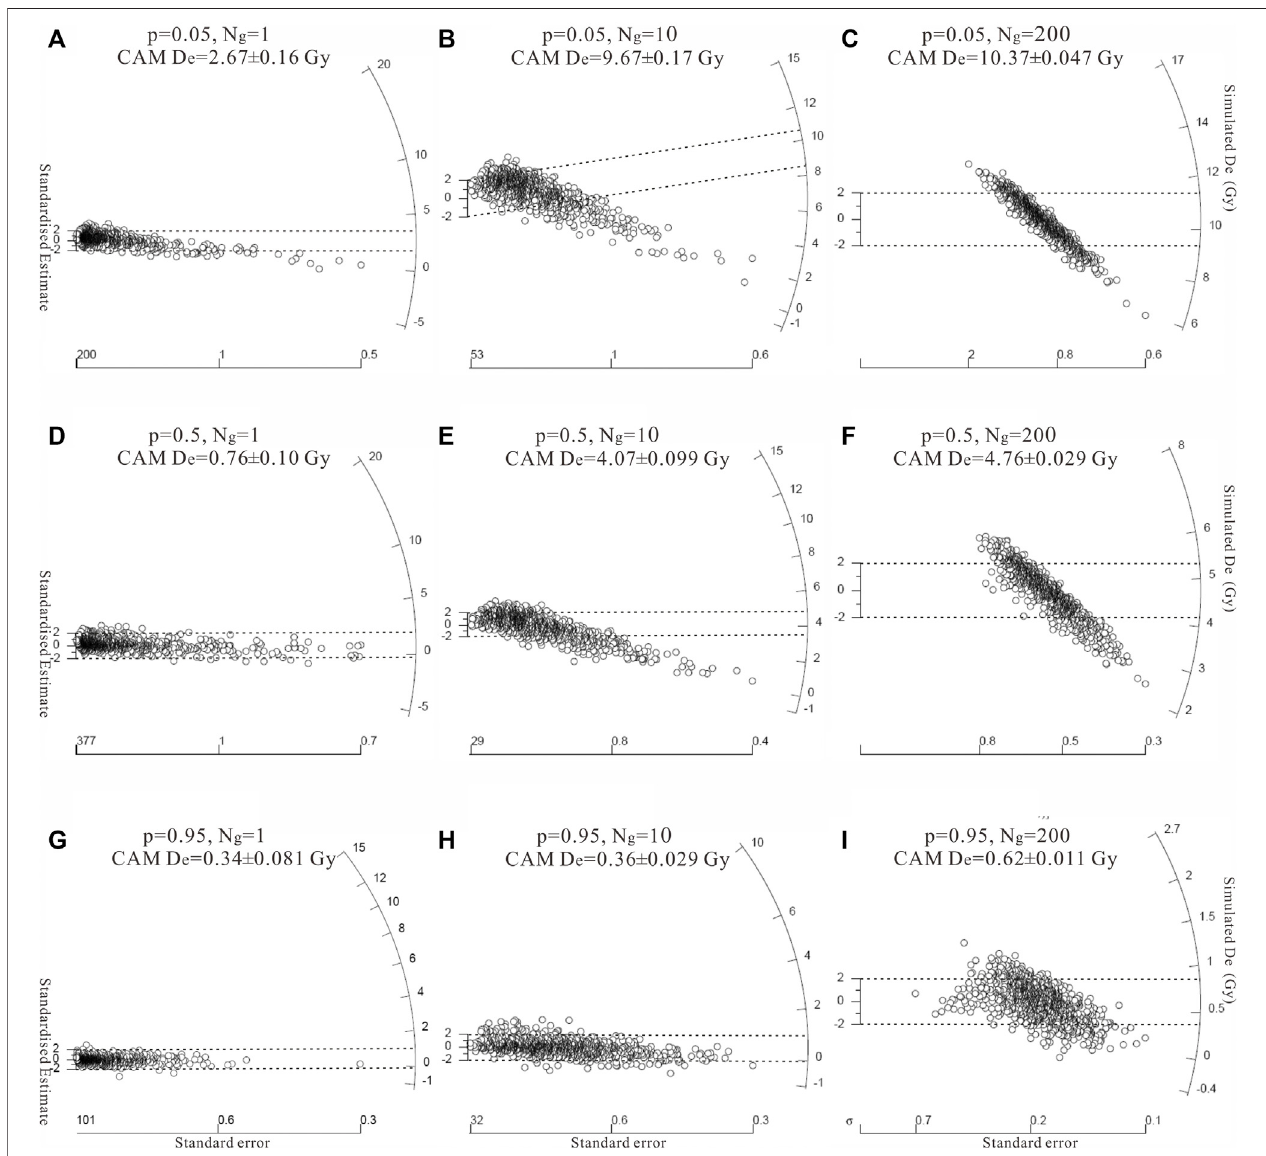
FIGURE7| D e distributions simulatedusingaburialdose of μ a =0.1 Gyandabaseline doseof μ q =50 Gy, fordifferentproportions offully-bleachedgrains( p )and different numbers of grains contained in an aliquot ( N g ). Each subplot consists of 1,000 D e values. The dashed lines indicate the two sigma range of the distribution.